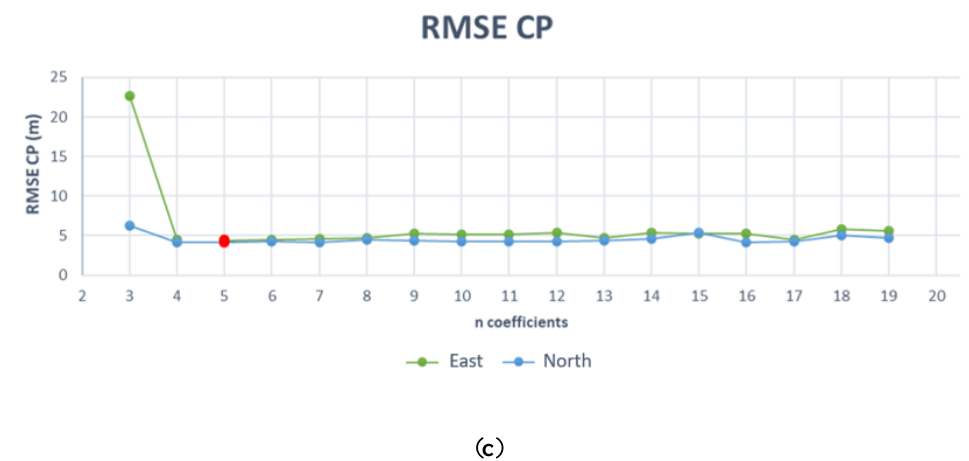
Table 11. Maximum accuracy achieved.